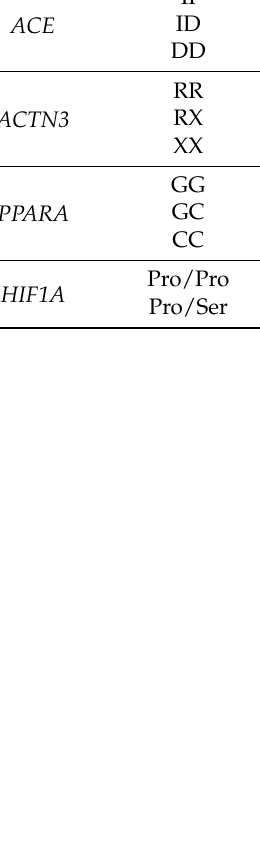
Table 2. Effect of the ACTN3 gene on the supercompensation effect in